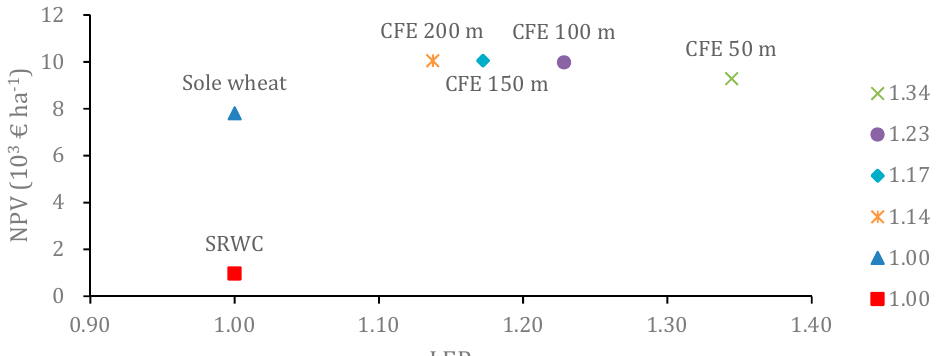
Figure 8. The relation between land equivalent ratio (LER) and net present value (NPV) for the six scenarios.